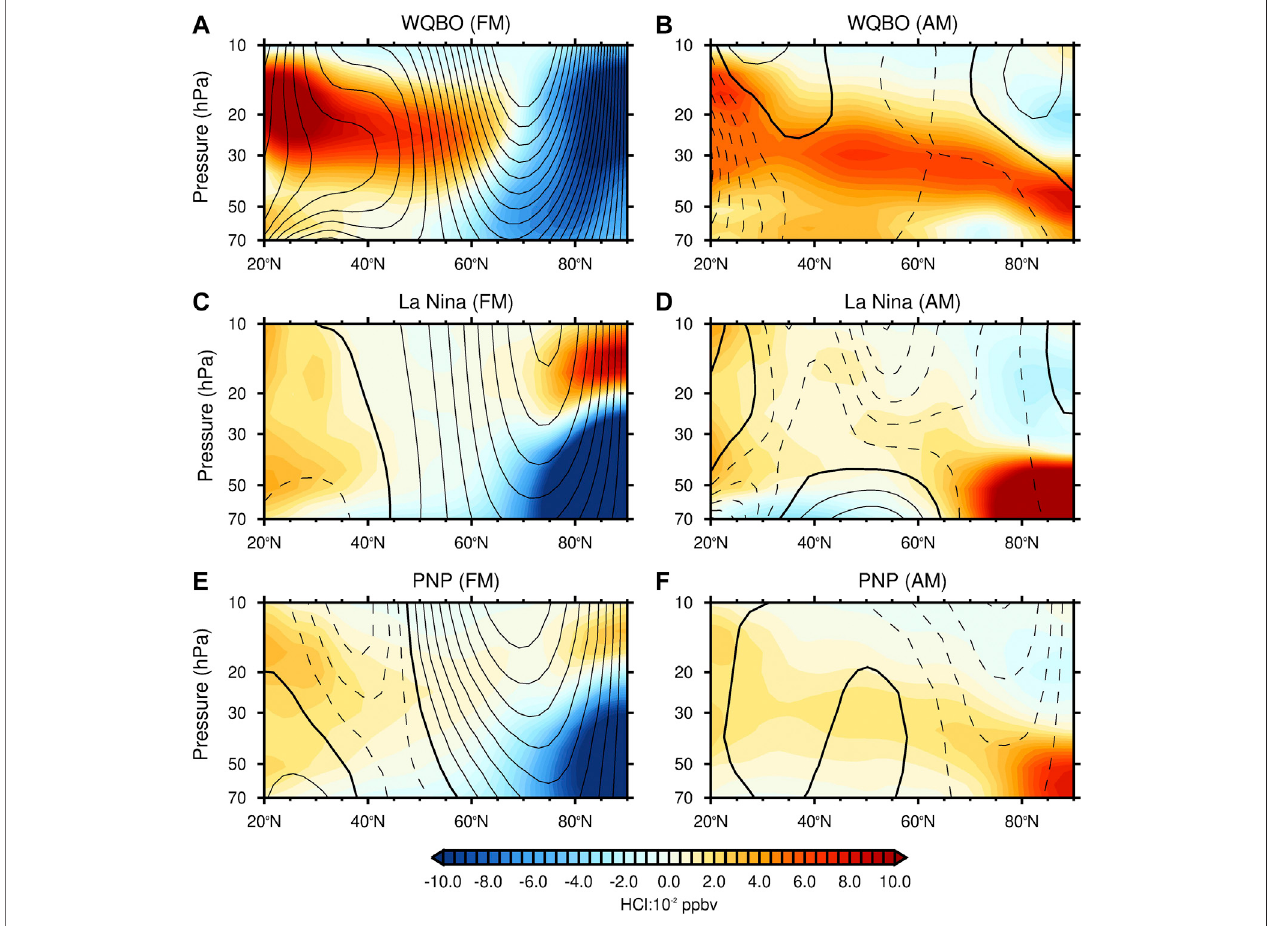
FIGURE8| Sameas Figure7 ,butfromtheWACCM4experiments. (A – F) DifferencesinHCl(colorshading)andU(contours)betweenR2andR3,betweenR2andR1 and between R4 and R1, respectively. The WQBO is identi fi ed when the zonal-mean zonal wind in R1 at 30 hPa in 10 ° S – 10 ° N is larger than a positive standard deviation.